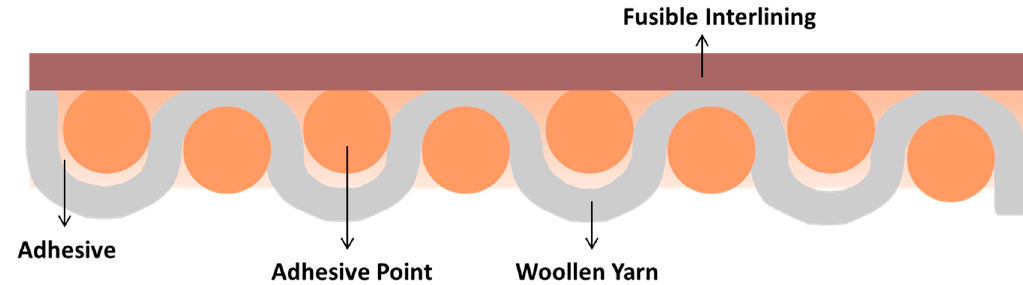
Figure 20. Fusible interlining (Reproduced from Reference [117] with permission from Springer Nature and Copyright Clearance Center, 2018).